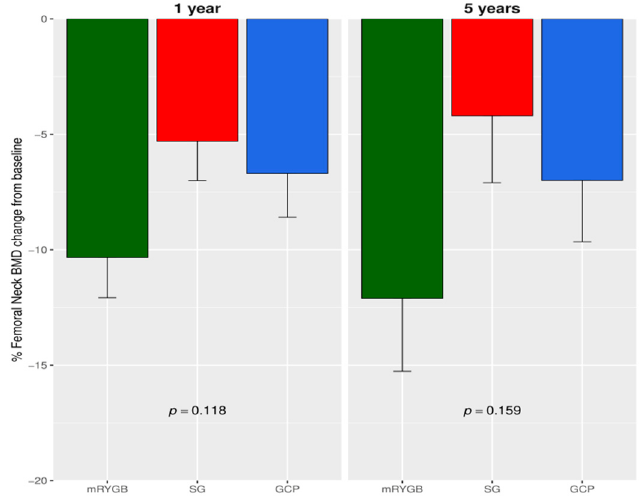
Figure 1. Percentage femoral neck BMD change at year 1 and 5 from baseline. BMD, bone mineral density; mRYGB, metabolic gastric bypass; SG, sleeve gastrectomy; GCP, greater curvature plication. p value result from comparing mRYGB with SG and GCP.